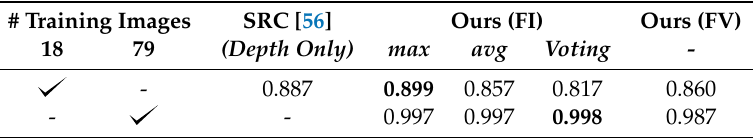
Table 5. Face recognition accuracy on the CurtinFaces dataset. Functions max , avg , and voting are detailed in Equations (6)–(8), respectively. SRC refers to the Sparse Representation Classifier proposed in [56]. In the last column, we report the Face Verification (FV) accuracy of the proposed method. The higher results are in